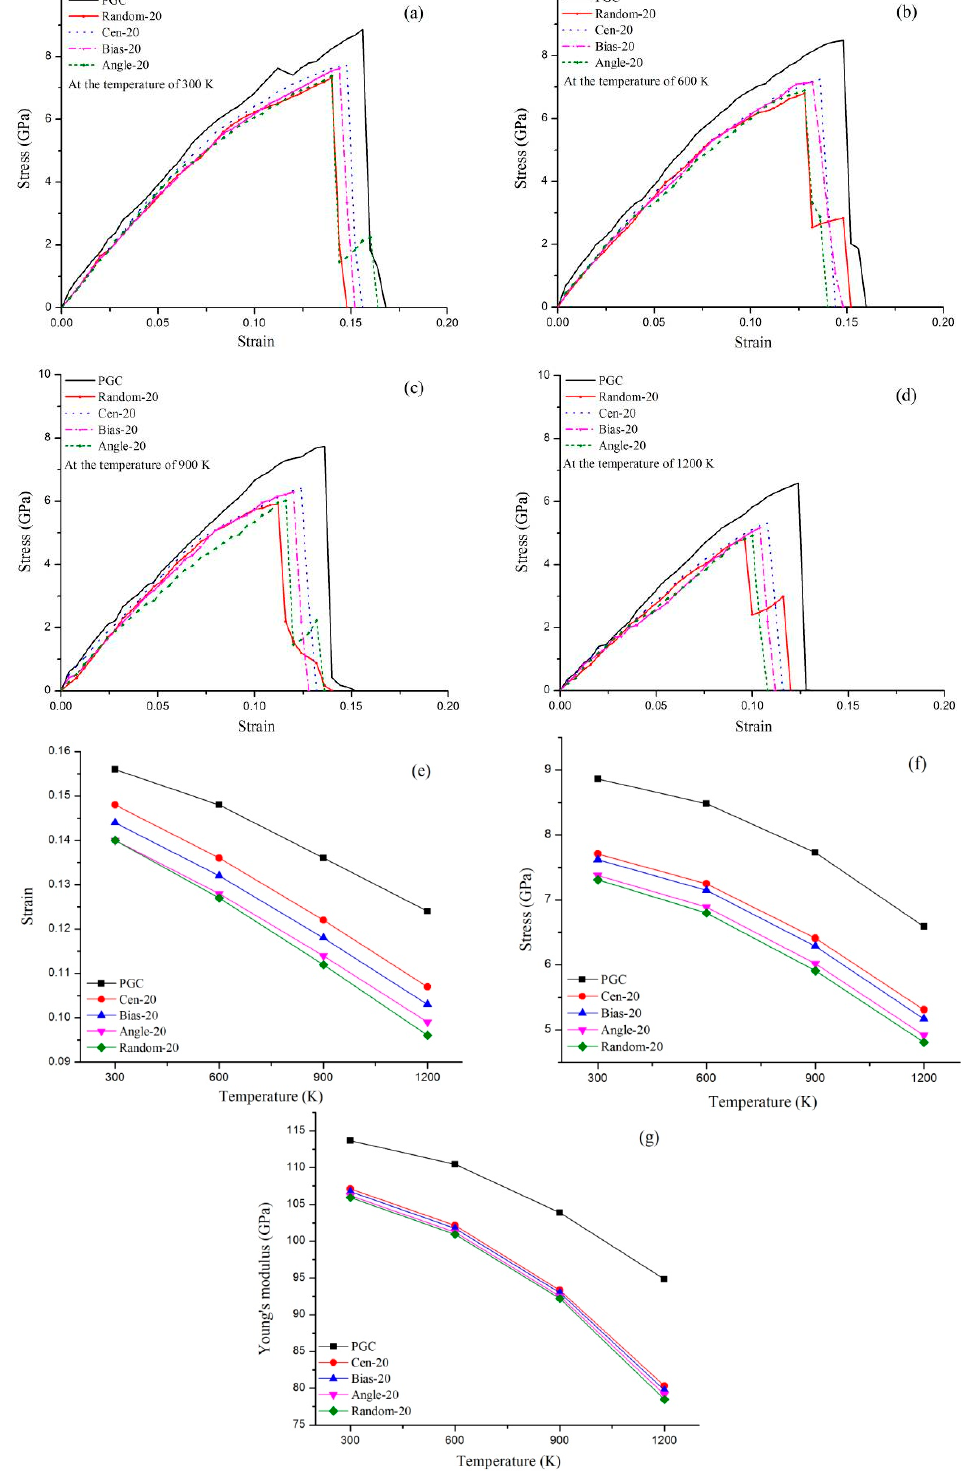
Figure 8. Stress-strain curve of graphene/copper layered composites with different types of defects at